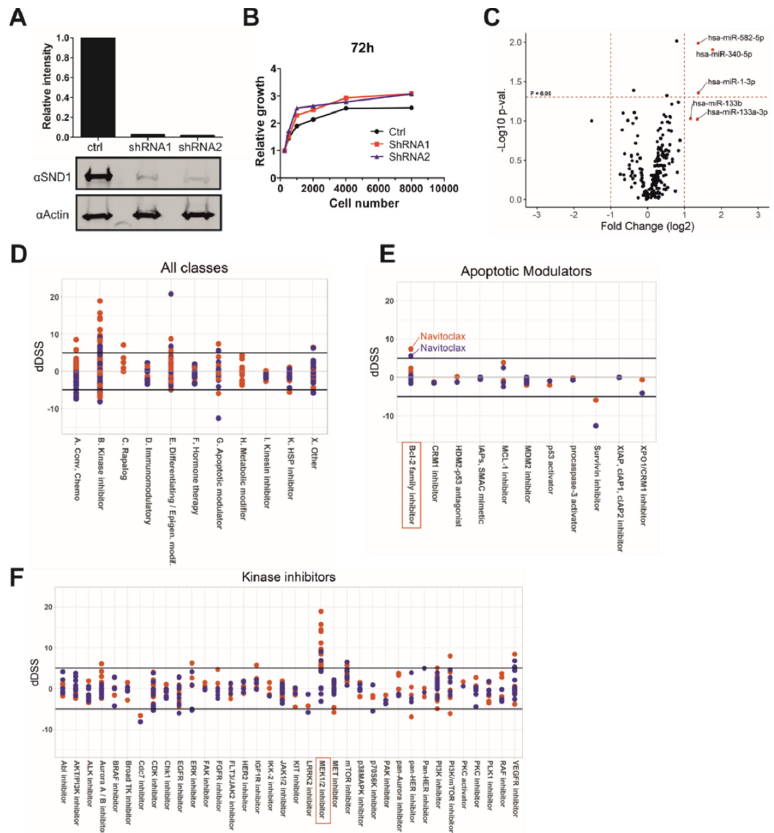
Figure 1. Silencing of SND1 induces the expression of tumor suppressor miRNAs and sensitizes cancer cells to certain anticancer drugs. ( A ) Western blot illustrating the silencing efficiency of stable cell lines, which express doxycycline-inducible shRNA constructs targeting SND1 (shRNA1 and shRNA2) or non-targeting control shRNA (ctrl). ( B ) Growth curve of stable cell lines after doxycycline treatment. CellTiter-Glo assay detected the amount of cell metabolism after 72 h from seeding of different cell densities (250–8000 cells). ( C ) Expression changes of 203 miRNAs, which expression was detected with RT-qPCR from SND1 silenced (shRNA1 and shRNA2) and control SW480 cell lines after doxycycline treatment. For statistical analysis, miRNA expression results were combined from shRNA1 and shRNA2 and the expression changes were compared to control shRNA cell line. N for each group (shRNA1, shRNA2 and control) is three. ( D – F ) The screen of 545 cancer drug compounds reveals the chemotherapeutic drug classes ( D ) and specific pathways from main drug classes ( E , F ), which sensitize SW480 cells to SND1 silencing. DeltaDSS (dDSS) presents the viability changes compared to control shRNA expressing cell line. dDSS value above five can be considered as a significant change. Red dots: shRNA1, dark blue dots: